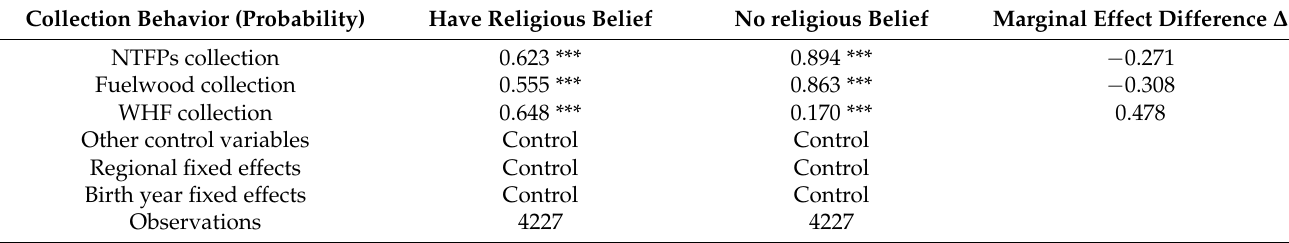
Table 8. The discrete marginal effect of religious belief on collection